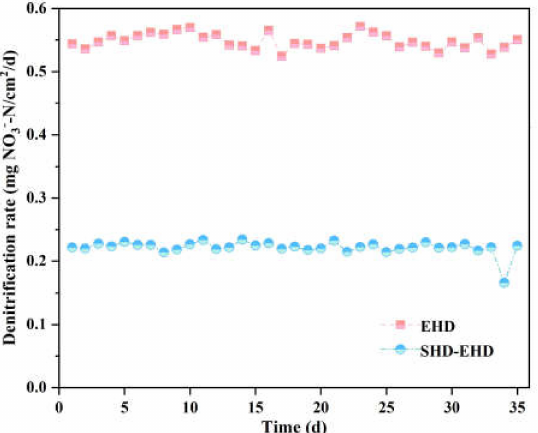
Figure 7. Comparison of denitrification rates of SHD − EHD and EHD under optimal conditions